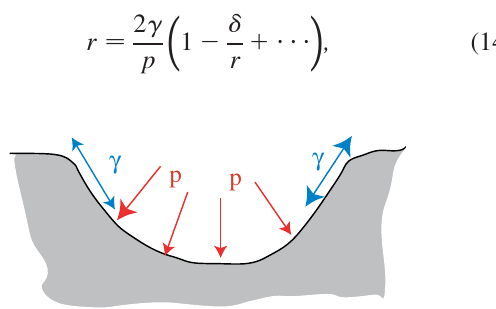
FIG. 14. Plasma pressure, p (red arrows), is opposed by the surface tension 2 (cid:3)(cid:6) r forces in the liquid